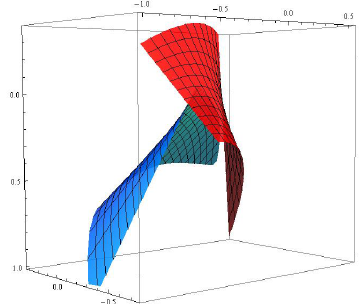
Figure 4. The red (blue) surface is the null scroll with generalized T ( B ) -lightlike ruling X 1 ( X 2 )